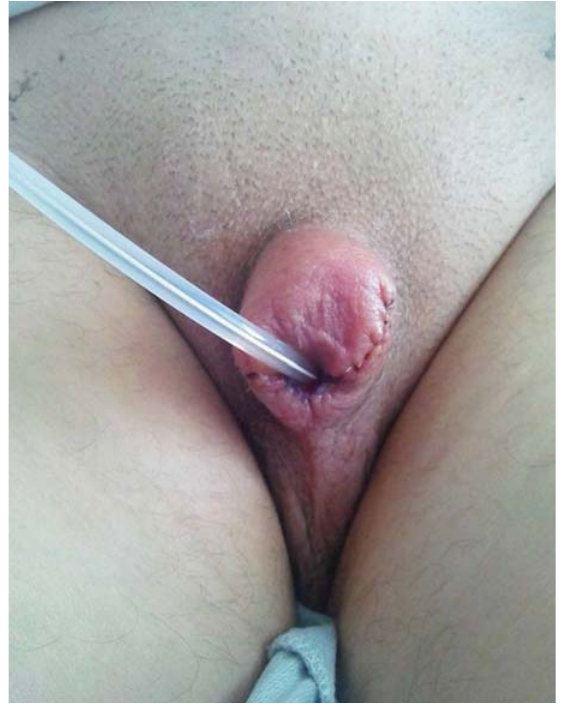
Figure 1a - During partial penectomy, after degloving of the penis inner wall of the previously drained periurethral abscess was exposed (arrowhead).